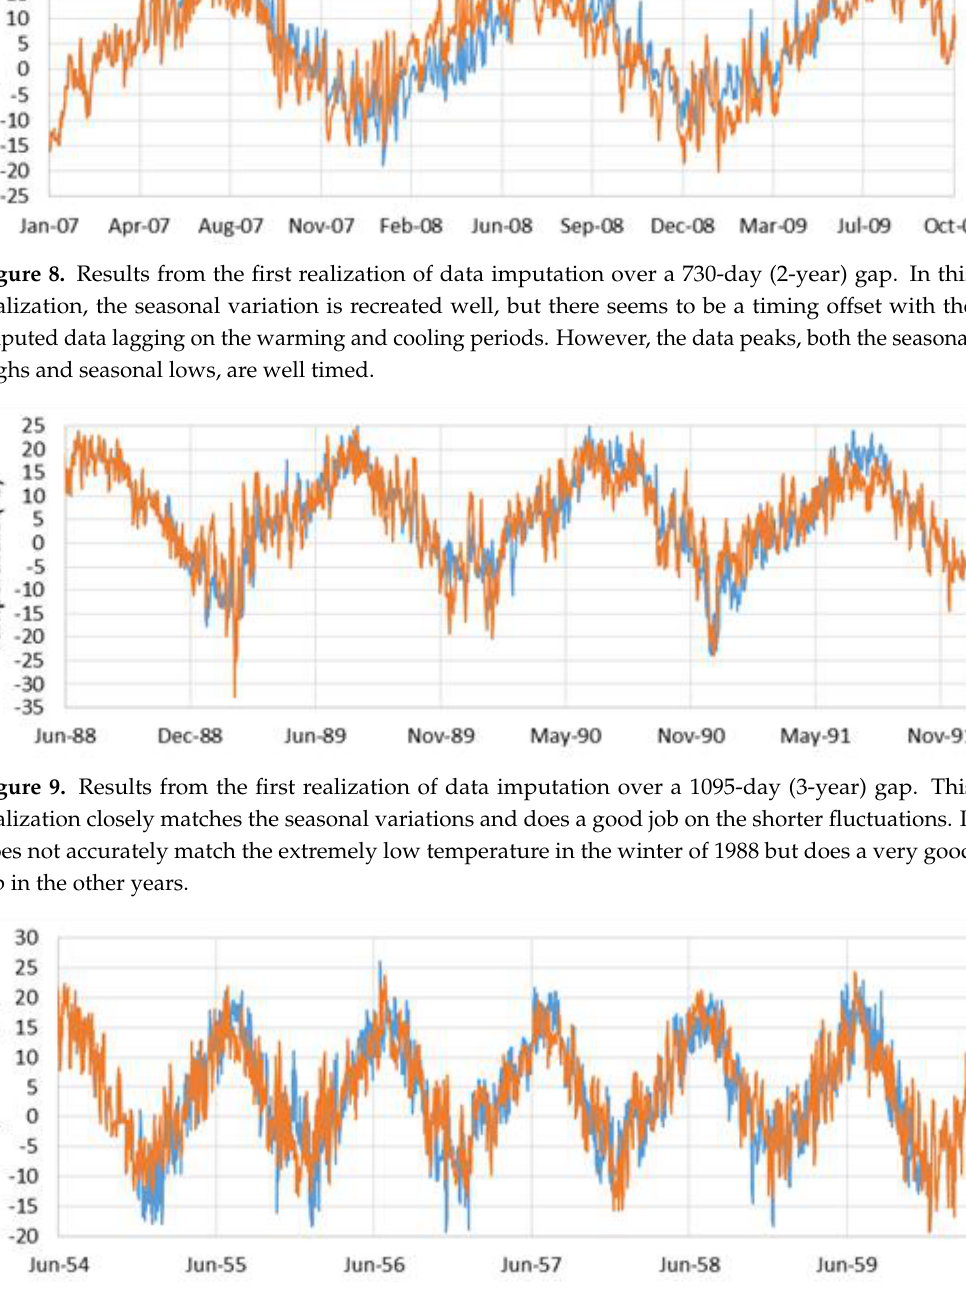
Figure 10. Results from the first realization of data imputation over a 1825-day (5-year) gap. Again, the seasonal variations are recreated well, however, the imputed data are significantly colder in the winter of 1955, with a few outlier cold days in the winter of 1957. The general fit is remarkable for such a long gap.